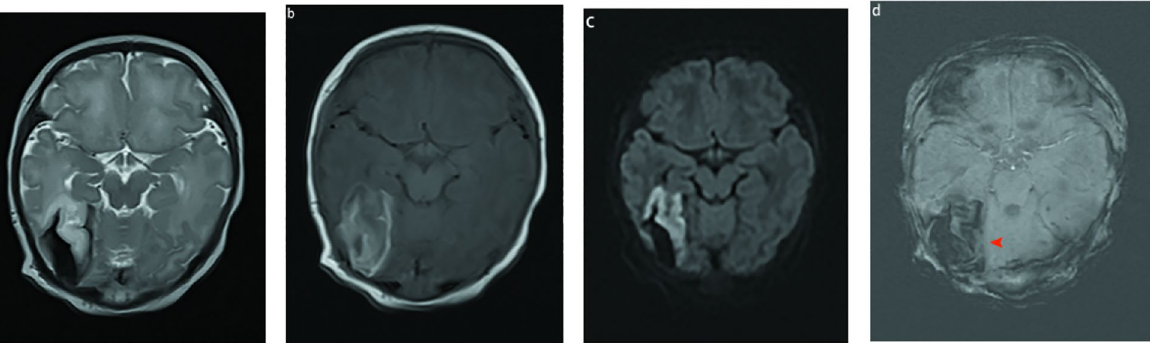
Figure 3. MR image of a full-term neonates with pattern C. The subpial hemorrhage shows hypointense on T2WI and hyperintense on T1WI. Hemorrhage is seen in the underlying cerebral cortex and white matter, resulting in a hyperintense on T1WI and T2WI (a-b). There was no restricted diffusion in the subpial bleed and hyperintense on underlying cerebral cortex and white matter (c). SWI shows magnetic susceptibility artifact blurs, making it diffcult to separate the subpial hemorrhage from underlying the cortical ribbon ( d, arrowhead). This combination of a dark subpial hemorrhage collection and the bright underlying cerebral cortex and white matter forms a yin-yang sign (a and c).